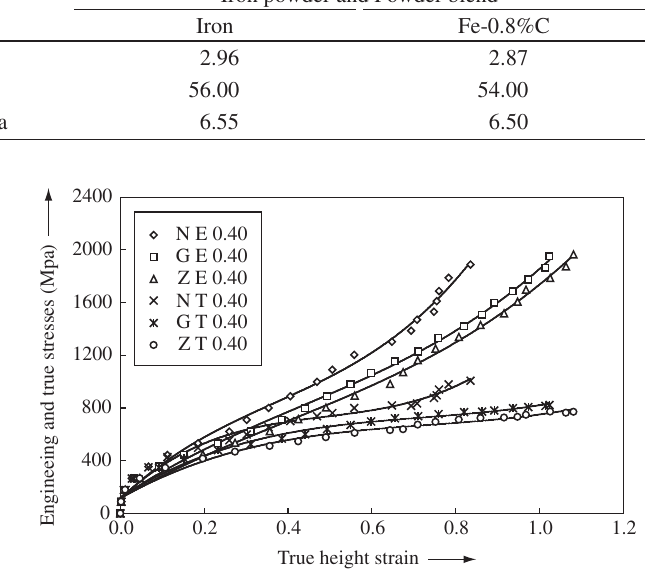
Figure 2. Relationship between applied stresses and the true height strain of sintered Fe-0.8%C P/M preform of 0.40 initial aspect ratio under the influ-